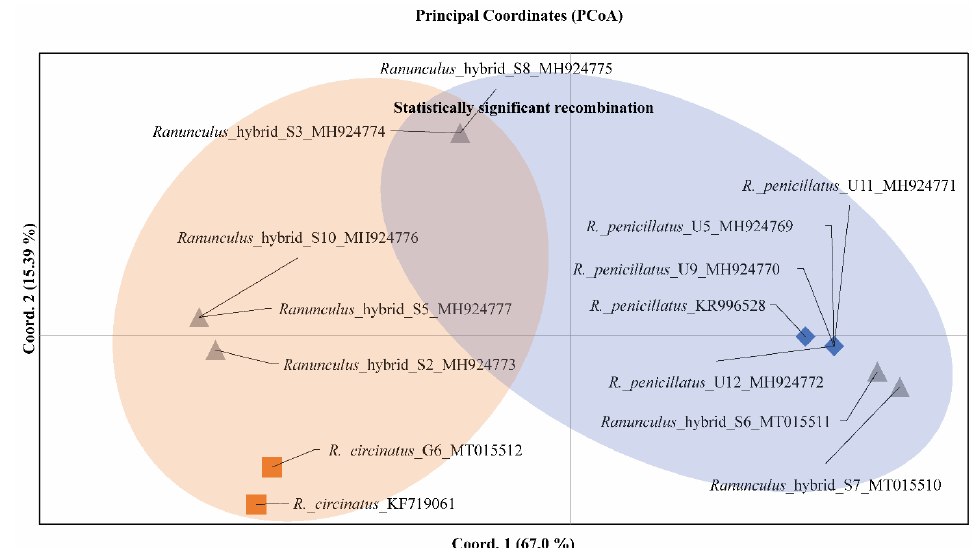
Figure 6. Principal coordinate analysis of supposed parental species ( R. circinatus (orange) and R. penicillatus (blue)) and Ranunculus hybrid from the Skroblus River (grey). The supposed parental species ( R. circinatus and R. penicillatus ) were grouped separately (Figure 6: orange zone— R. circinatus ; blue zone— R. penicillatus ). Principal coordinate analysis (PCoA) also